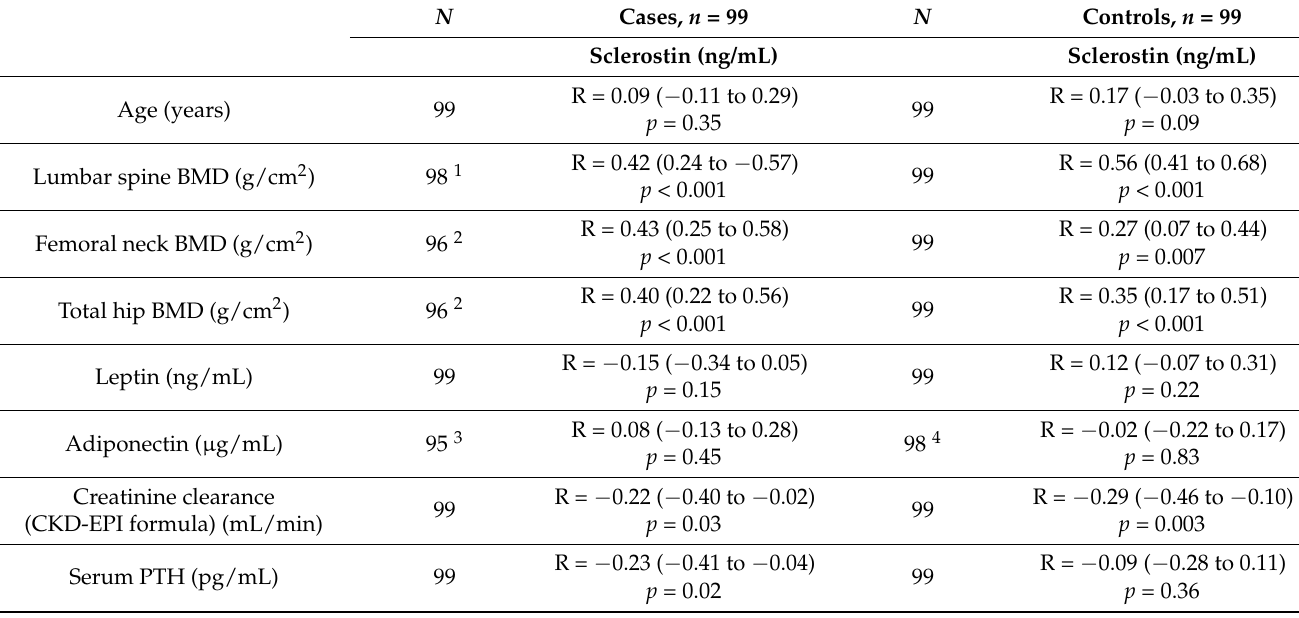
Table 2. Correlations between circulating sclerostin and parameters of